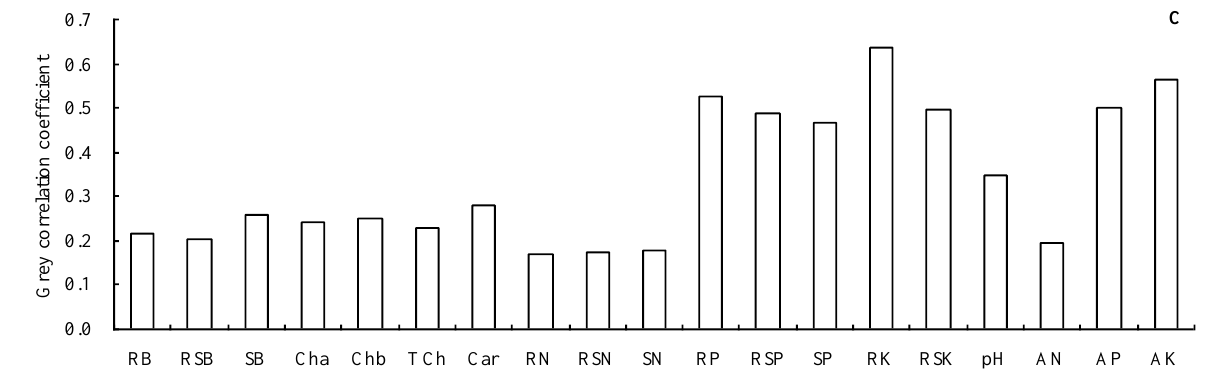
Figure 3. Grey correlation coefficients. ( A ) Grey correlation coefficient of the biomass, photosynthetic pigment content, rootstock root total N content, rootstock stem total N content, total P content, and total K content with the scion total N content; ( B ) grey correlation coefficient of the biomass, photosynthetic pigment content, total N content, rootstock root total P content, rootstock total P content, and total K content with the scion total P content; ( C ) grey correlation coefficient of the biomass, photosynthetic pigment content, total N content, total P content, rootstock root total K content, and rootstock stem total K content with the scion total K content. RB — rootstock root biomass; RSB — rootstock stem biomass; SB — scion biomass; Cha — chlorophyll a content; Chb — chloro-